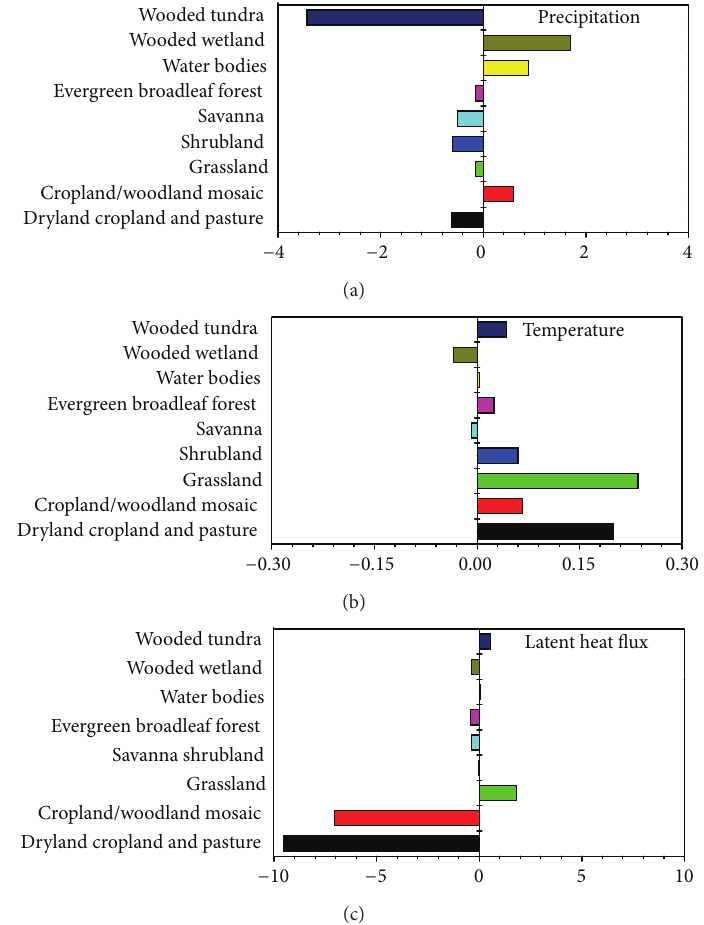
Figure 4: The zonally averaged difference of precipitation (mm), temperature ( ∘ C), and latent heat flux (W/m 2 ) of different land covers in Brazilian Amazon in